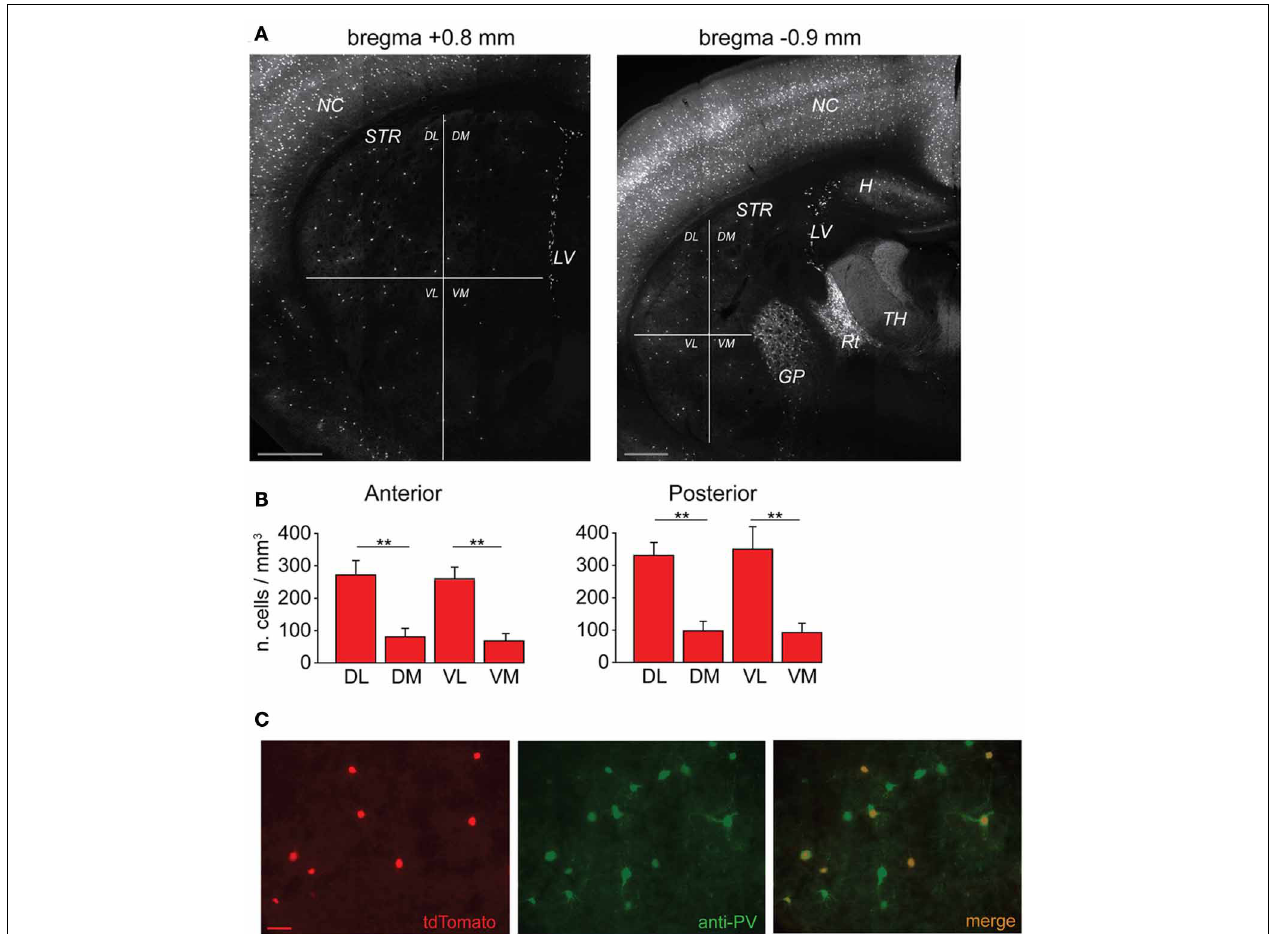
FIGURE 1 | Anatomical distribution of striatal FSIs and specificity of parvalbumin expression. (A) PV + -tdTomato-labeled FSIs in mouse acute slices. FSIs were prevalently distributed in the dorsolateral (DL) and ventrolateral (VL) sectors of the striatum (STR) as compared to dorsomedial (DM) and ventromedial (VM) quadrants. Examples of anterior (left) and posterior (right) 50 μ m-thick striatal sections are shown ( + 0.8mm and − 0.9mm from bregma, respectively). Note the greater density of tdTomato labeled cells in other areas such as neocortex (NC), globus pallidus (GP), reticular thalamic nucleus (Rt) and lateral ventricles (LV), and hippocampus (H), while non-reticular thalamic nuclei (TH) contain densely stained fibers but